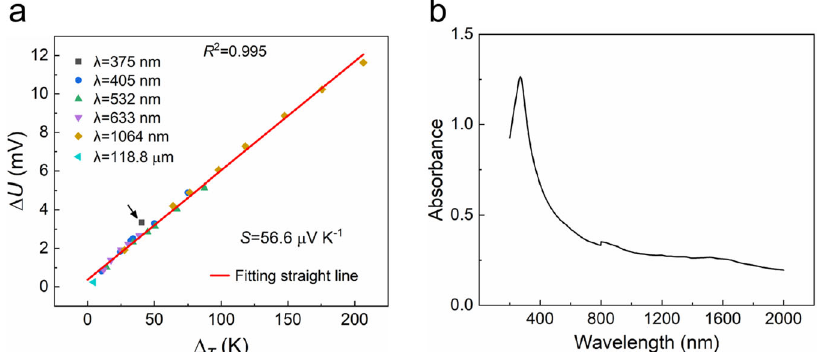
Fig. 7 Thermal and optical properties of CNTF. a The Δ U across the sample versus the corresponding Δ T to determine the Seebeck coef fi cient ( S ) of CNTF. b Absorption spectrum of